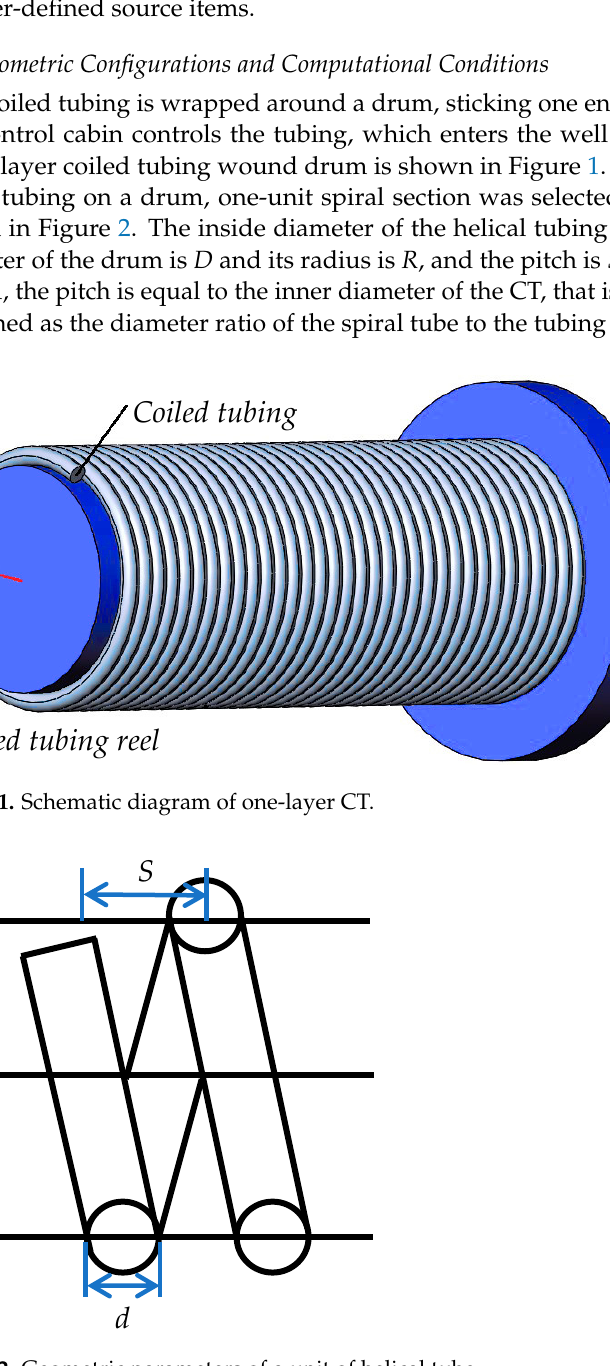
Figure 2. Geometric parameters of a unit of helical tube.